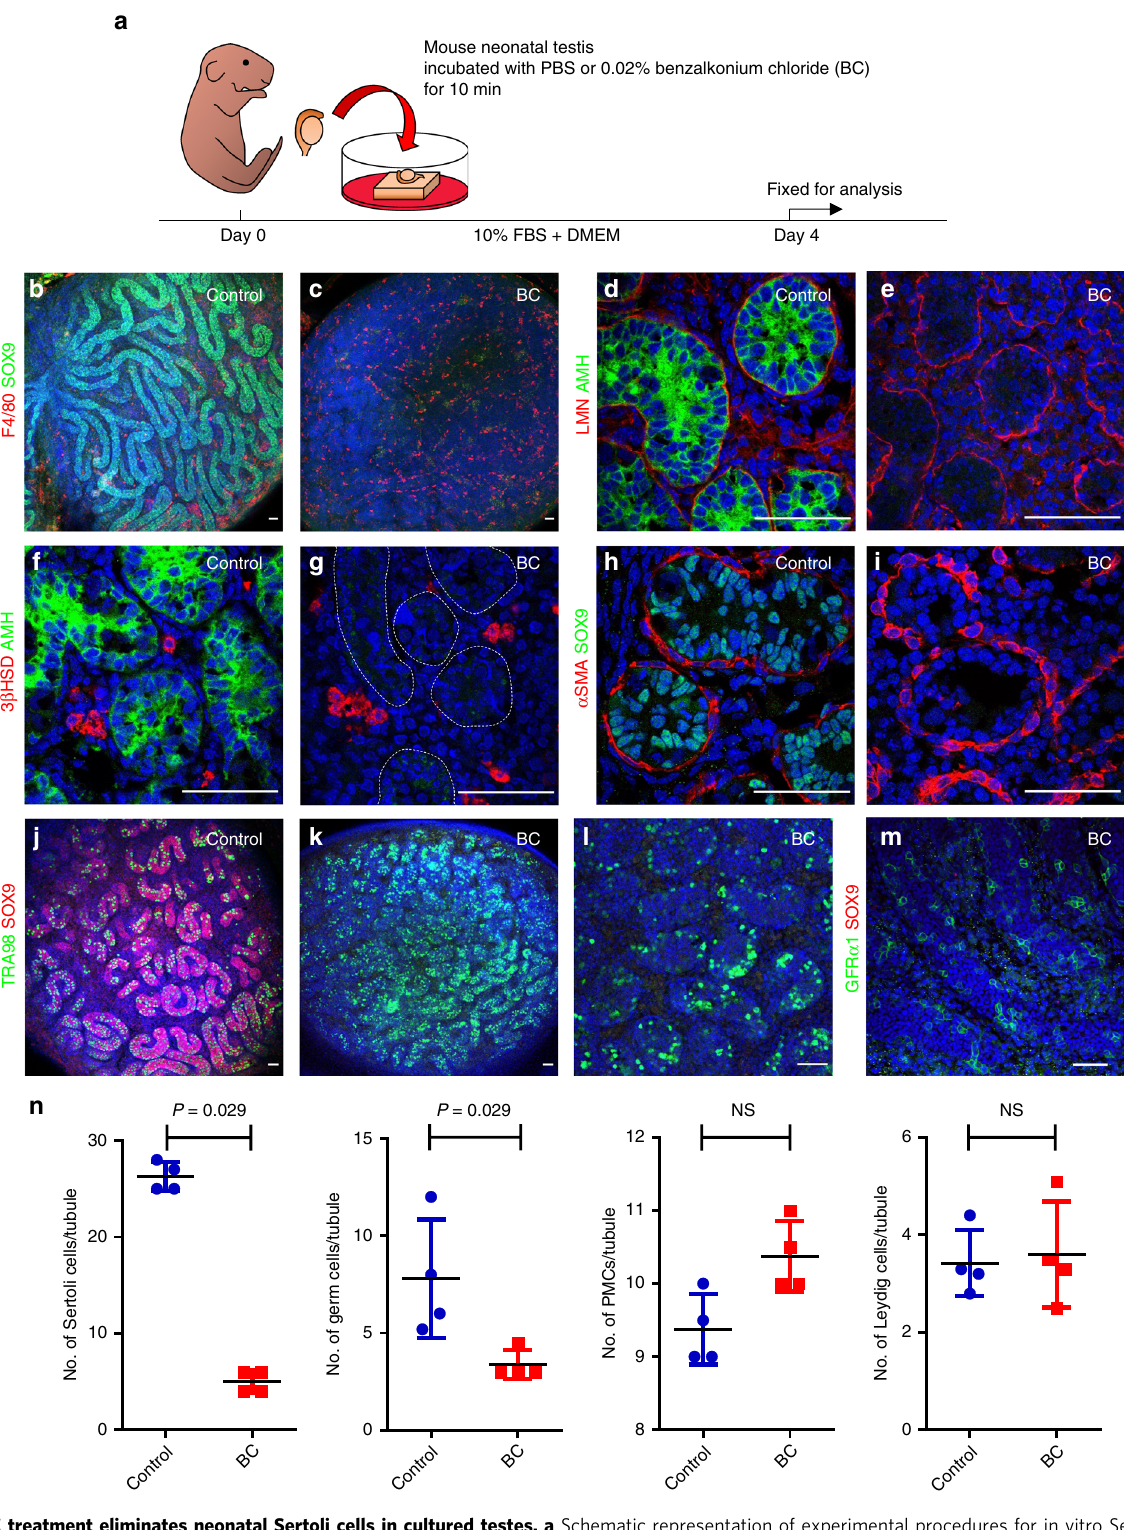
Fig. 1 BC treatment eliminates neonatal Sertoli cells in cultured testes. a Schematic representation of experimental procedures for in vitro Sertoli cell ablation. b – m In all, 1.5 dpp mouse testis cultured for 4 days following incubation with b , d , f , h , j PBS or c , e , g , i , k – m 0.02% BC for 10 min. Samples were stained with antibodies against b and c SOX9 (green), F4/80 (red); d , e AMH (green), LMN (red); f , g AMH (green) and 3 β HSD (red). Hoechst (blue) was used to stain nuclei. Expected seminiferous cord domain is marked by dotted lines. h , i SOX9 (green) and α SMA (red). j – l SOX9 (red) and TRA98 (green). m SOX9 (red) and GFR α 1 (green). Ten independent experiments. Scale bar: 50 µ m. n After treatment with 0.02% BC, numbers of Sertoli cells and germ cells/tubule were reduced relative to untreated controls; however, counts of residual Leydig and myoid cells were similar to untreated controls. Data were analyzed from four biologically independent samples examined over three independent experiments and expressed as mean ± SE; (NS) not signi fi cant. Statistical analysis was performed using an unpaired t test, Kolmogorov – Smirnov test. See experimental procedures for details of counting